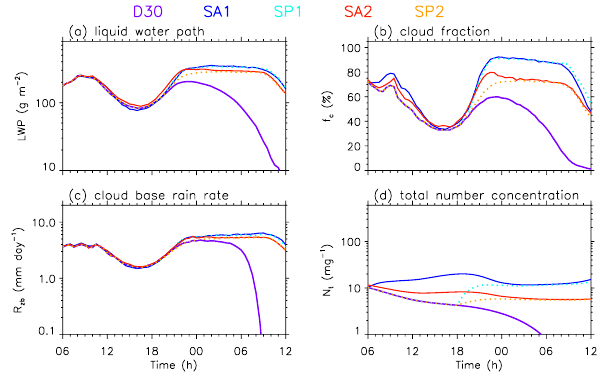
Fig. 10. As in Fig. 3 but for experiment D30 and four other sensitiv- ity experiments with different CCN source strengths and start times. Note that the time axis is different from Fig. 3. The source strengths of the first set (SA1 and SP1) and the second set (SA2 and SP2) are 3.6mg − 1 h − 1 and 0.72mg − 1 h − 1 . “A” and “P” indicate the source starting time of 6a.m. and 6p.m. (local time), respectively. Dotted linestyles are used to help distinguish between overlapping